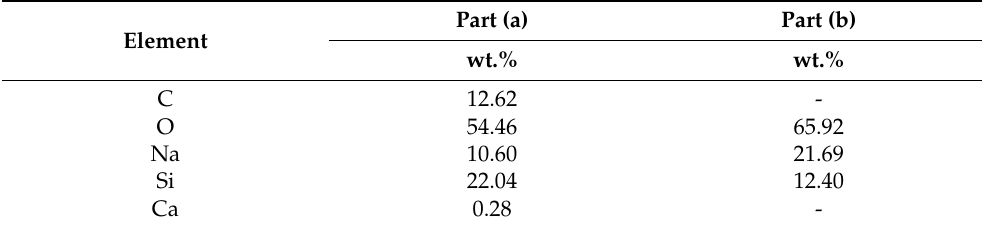
Figure 17. Color difference of ( a ) expended char and ( b ) residue across the thickness of the intumescent geopolymer coating after the fire test (sample S7). Table 12. EDX result of different area across the thickness of the intumescent geopolymer coating after fire test (sample